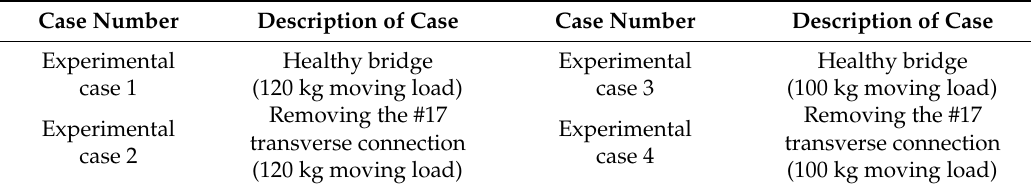
Table 2. Descriptions of all cases for the experimental